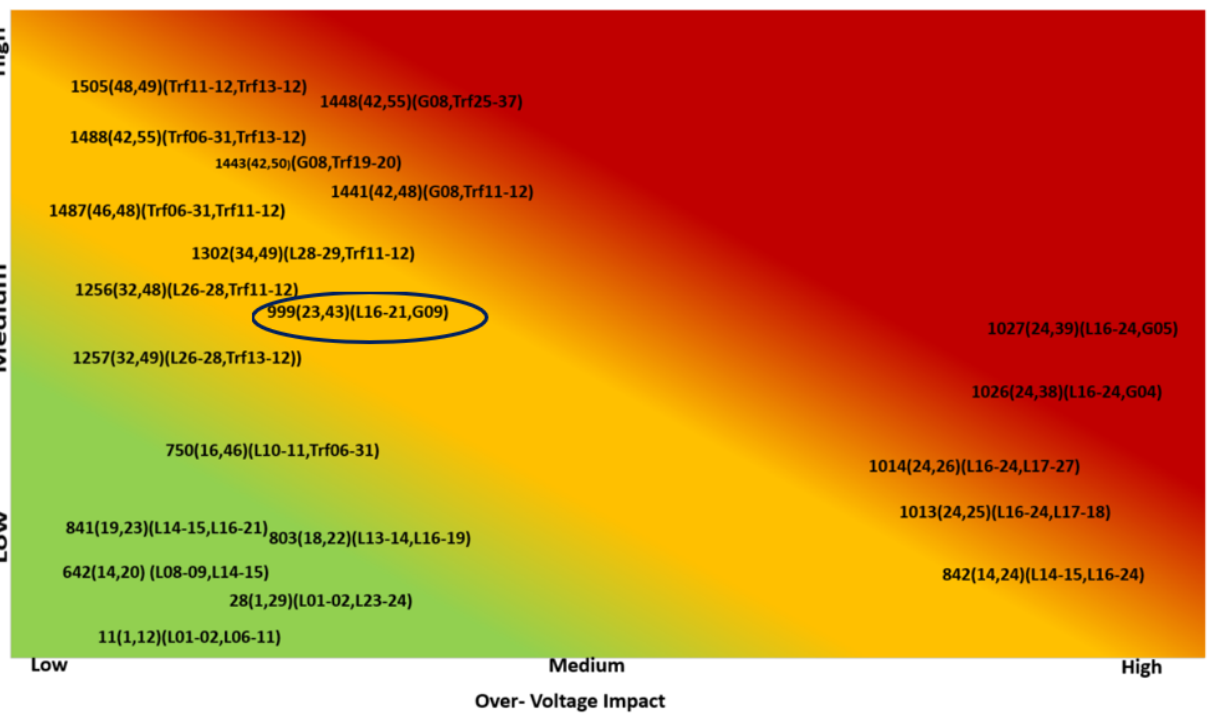
Figure 6. Risk-based overvoltage contingency chart. For example, contingency number 999 (indicated) in which the component number 23 (L16–21) and component number 43 (G09) are involved fall in the medium impact medium probability (MIMP) area.